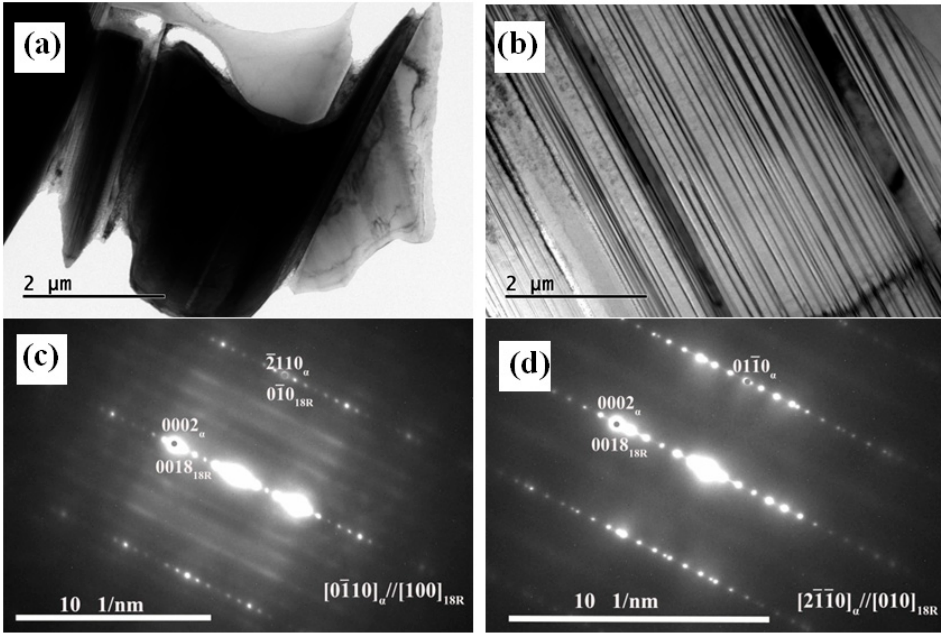
Figure 5. TEM analysis results of the as-cast 1.5Zn alloy: ( a ) bright field image of the block phase, ( b ) bright field image of the lamellar structure, ( c ) selected area electron diffraction of the block phase, and ( d ) selected area electron diffraction of the lamellar structure.